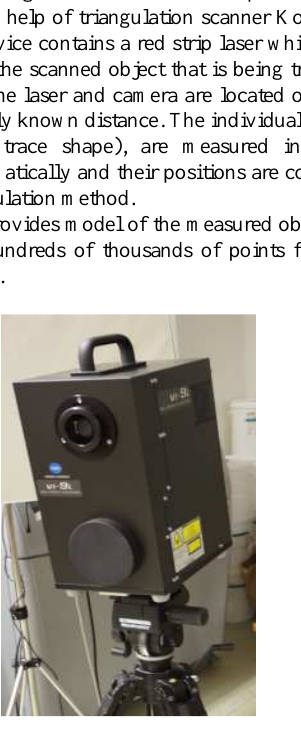
irregular network (TIN), which represents the surface of the scanned object on the basis of measured 3D points of the